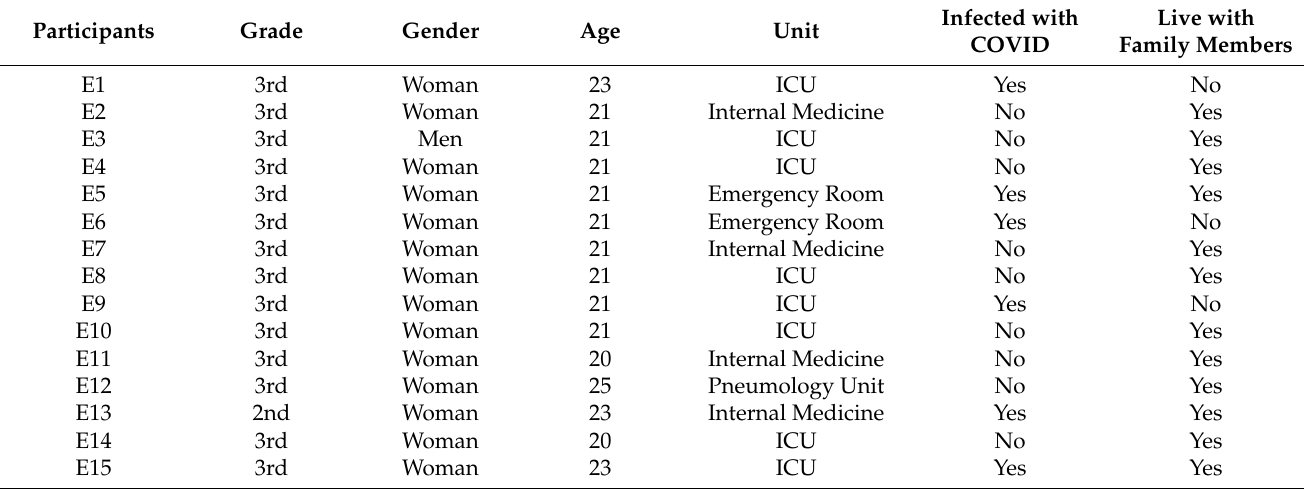
Table 2. Participants’ demographic data.